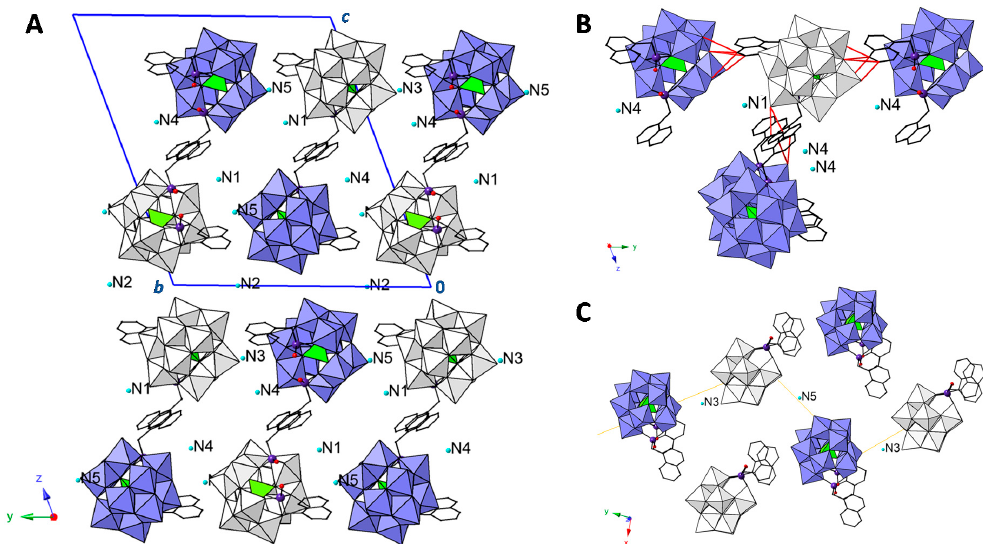
Figure 3. View of the crystal packing of compounds TBA-1 and TBA-2 along the [100] direction ( A ); Connectivity between POMs through intermolecular C–H···O POM hydrogen bonds (depicted as red lines) within bilayers ( B ); Projection of a layer along the [001] direction where the N3 and N5 TBA cations connect POMs of the same z level in a zigzag mode ( C ). Color code: same as in Figure 2, crystallographically independent POM clusters are depicted in blue and gray. Butyl groups from TBA cations and aromatic H atoms are omitted for clarity.